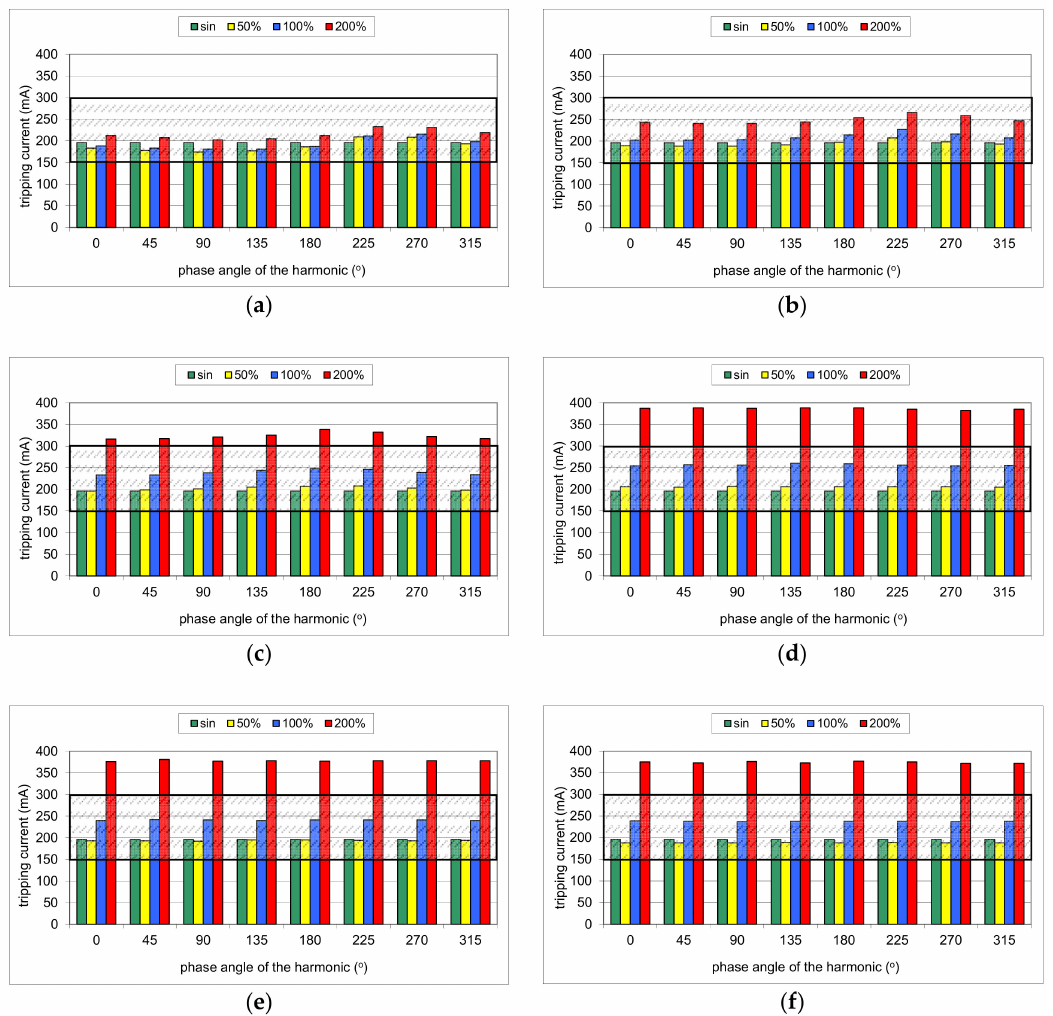
Figure 12. Tripping current of the A-type 300 mA RCD (no. RCD300_1) for testing waveform comprising the fundamental and the following high-frequency components: ( a ) 3 rd harmonic; ( b ) 5 th harmonic; ( c ) 7 th harmonic; ( d ) 11 th harmonic; ( e ) 23 rd harmonic; ( f ) 49 th harmonic. Tested percentages of harmonic-to-fundamental: 50%, 100%, and 200%, and phase angles of the harmonic: 0 ◦ , 45 ◦ , 90 ◦ , 135 ◦ , 180 ◦ , 225 ◦ , 270 ◦ , 315 ◦